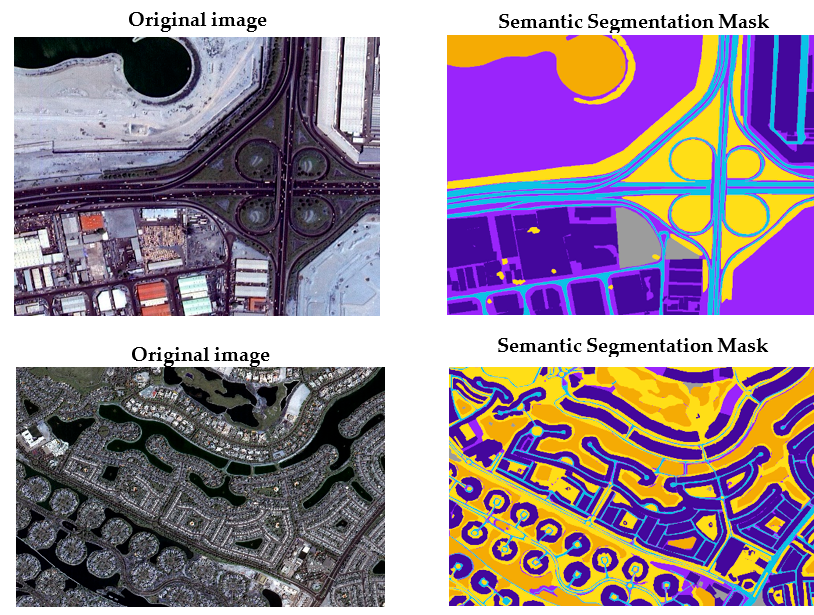
Figure 1. Sample of training and validation dataset.